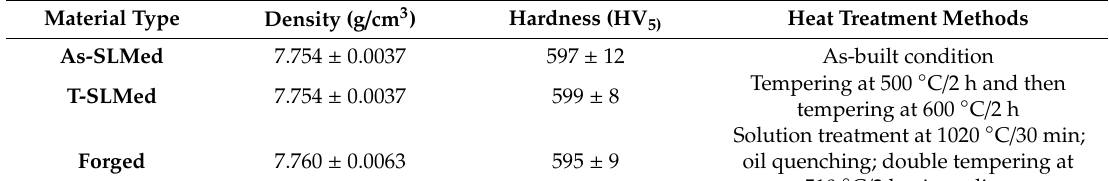
Table 2. Experimental work data of the used materials.